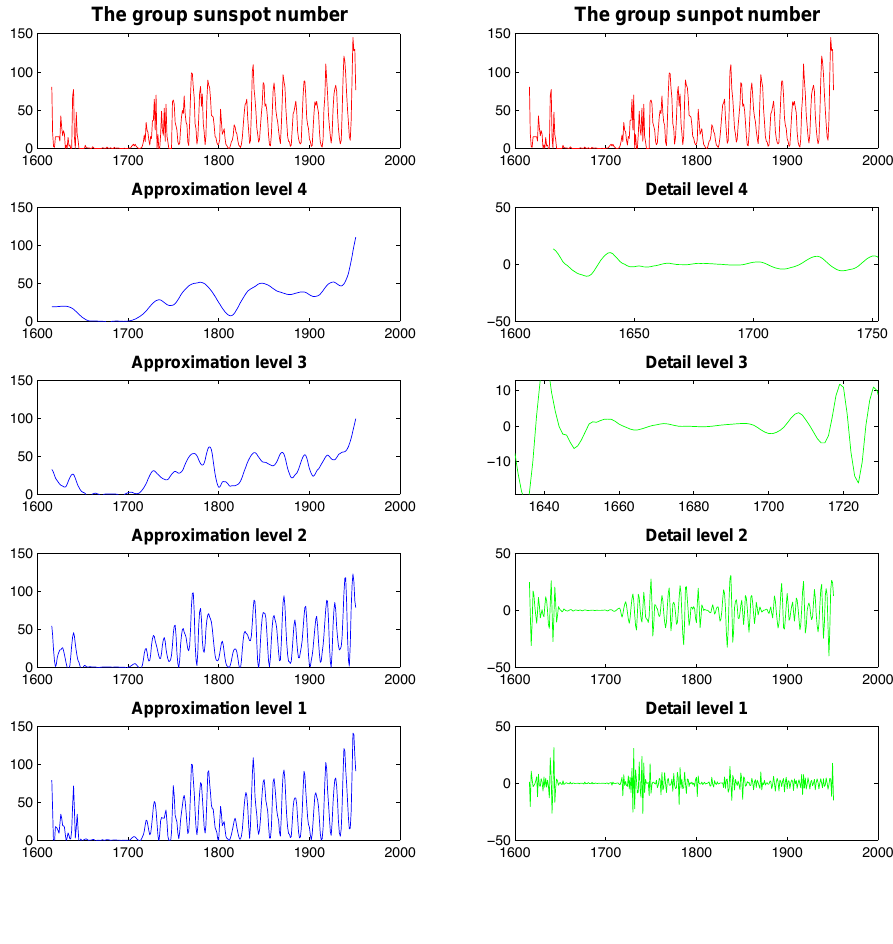
Fig. 6. Multi-resolution analysis of the group sunspot number. The 11-year cycle is not present during the Maunder Minimum (zoomed in period) at detail level